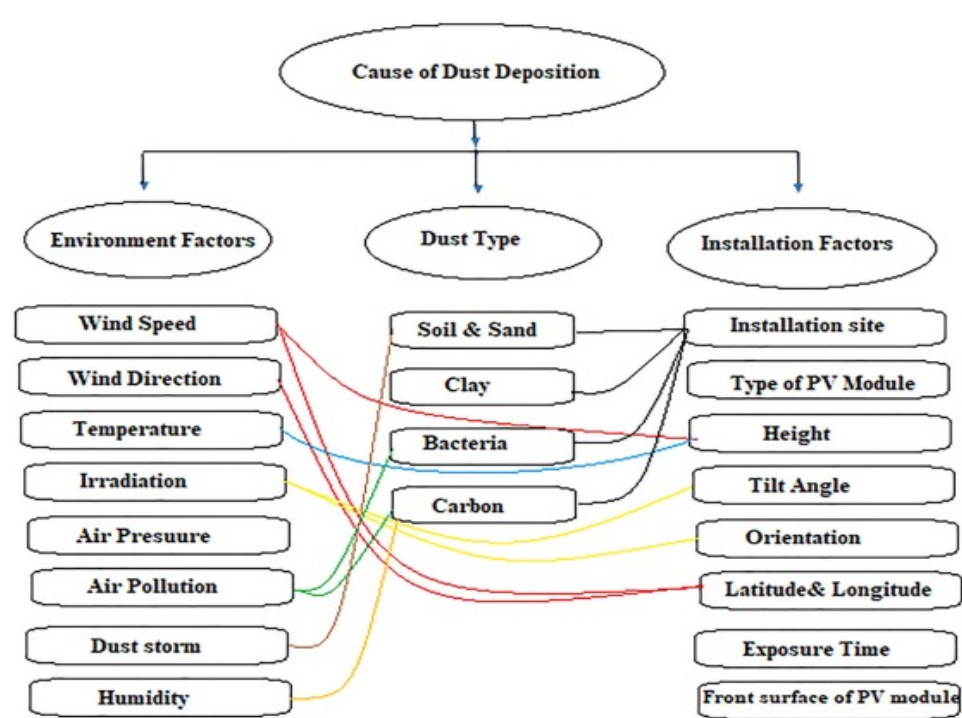
Energies 2022 , 15 , 7595 Figure 19. Factors causing dust deposition on PV module surfaces [112]. Figure 19. Factors causing dust deposition on PV module surfaces [112].